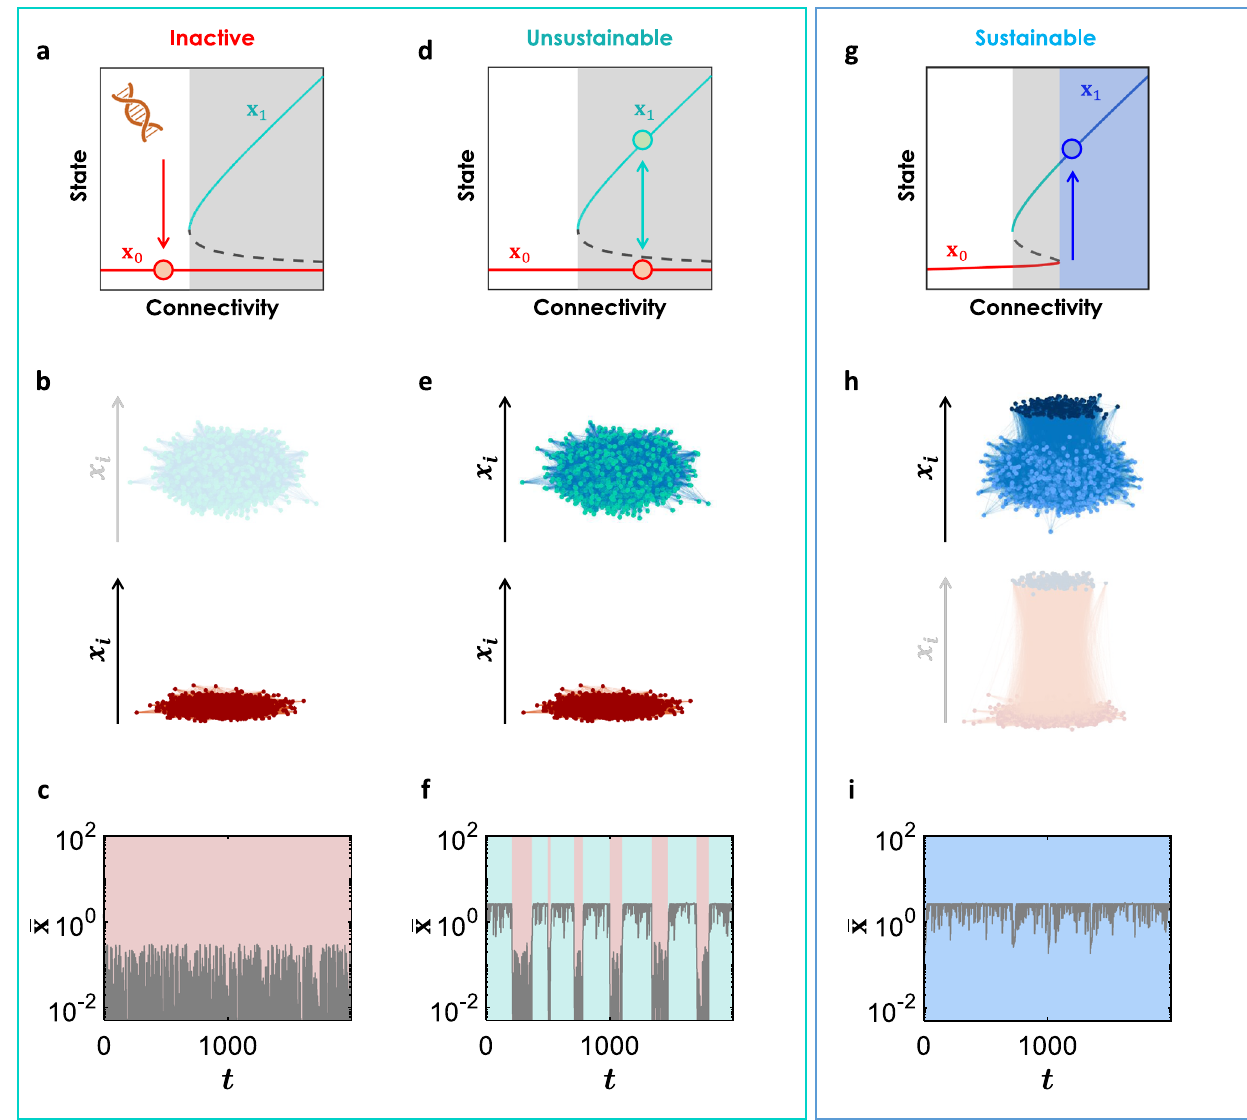
Fig. 1 The challenge of an unsustainable network and how to make it sustainable. a Diagram of regulatory dynamics showing two states, inactive x 0 and active x 1 . For weak connectivity, only x 0 exists, thus the system resides in the inactive phase. b For weak connectivity, there is no active stable state (cyan, very light), but just the inactive state (red). The vertical ( z ) coordinate represents the activity of each node. c Adding random perturbations (noise) to the activities does not help to activate the network since a functional stable state does not exist, thus the average activity stays low all the time. d For dense connectivity, both states are stable, such that there exists a bi-stable region (gray shade). e A system located in the bi-stable regime, demonstrates two stable states, active (cyan) and suppressed (red). Thus, x 1 is unsustainable in this region since the inactive state x 0 also exists. f An implication of the bi- stability is that adding random perturbations (noise) to the activities, results in spontaneous system transitions between the active (cyan) and inactive states (pink) since both are stable in the unsustainable phase. Here, as in ( c ) and ( i ), the noise was taken, for simplicity, to be discrete, since it is ef fi cient enough for exposing if the system is sustainable. Stochasticity is a fundamental feature of gene expression appearing by randomness in transcription and translation 56,57 , thus adding a noise here re fl ects a realistic phenomenon. g , h Here, we consider the same system as in ( d ), but we control a fraction of the system (dark blue circles), ρ , and hold it with a constant high value, Δ . Due to this intervention, the low-functional state vanishes which makes the system sustainable. i When we control a fraction of nodes with high activity, perturbations such as those in ( f ) are not capable to de fl ect the system from the active state, since the inactive state disappears. Namely, the control makes the system